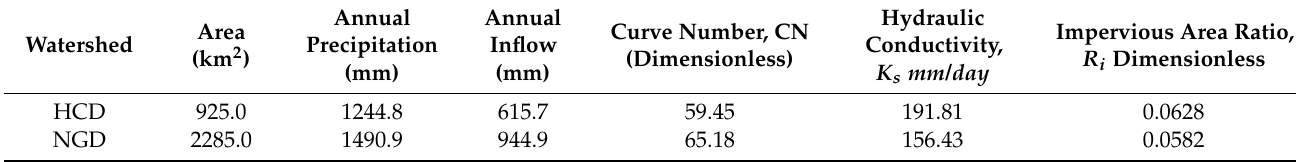
Table 2. Information of study